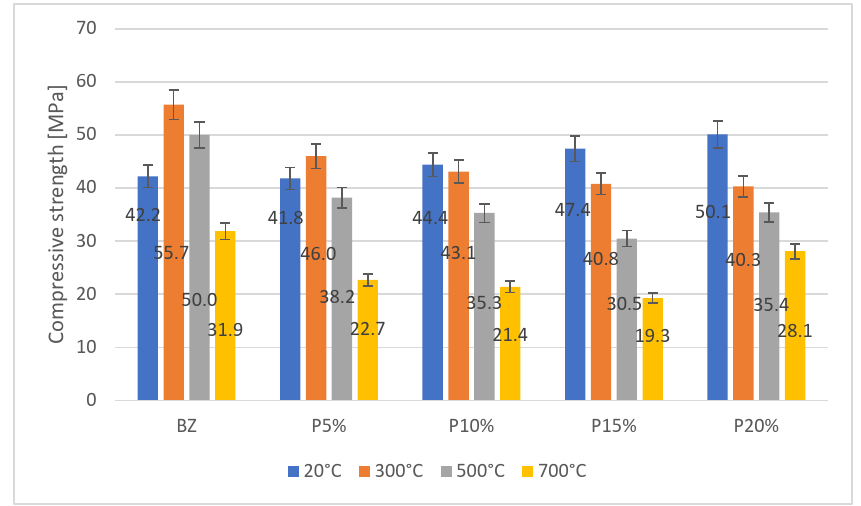
Figure 12. Average compressive strength of thermally loaded samples.